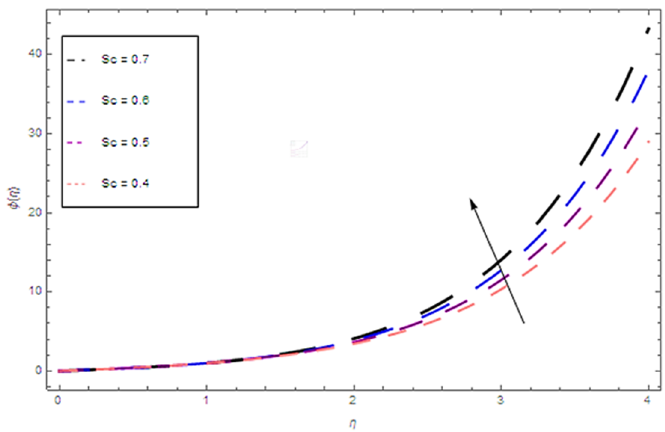
Ω = 1,Pr = 1, S = 0.5, Nb = 0.7, Nt = 0.6, M =